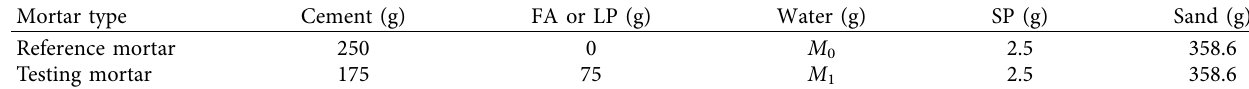
Table 1: Mortar mix proportions for powder equivalence coefficients of FA or LP.